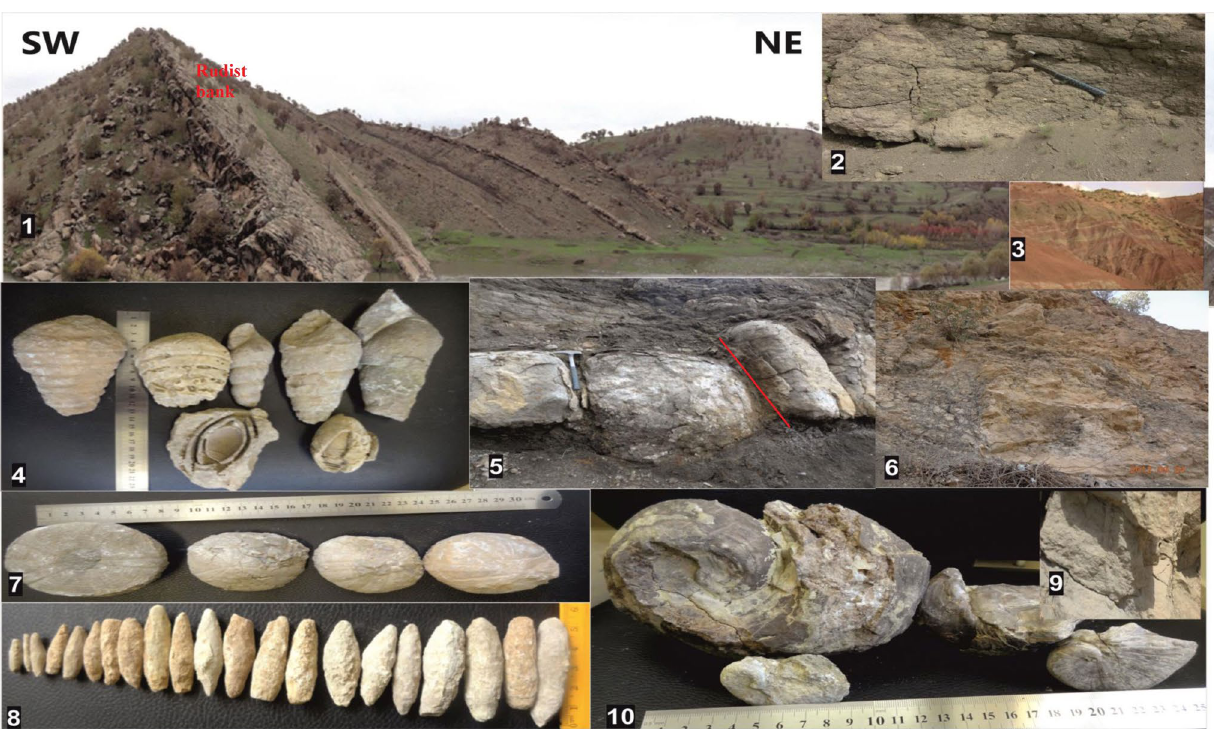
Fig. 7 1. Upper part of Aqra fn. 2. Incised valley fill (SBT.1). 3. Swais Group. 4. Turritella and Acteonella. 5. and 6. Slumped blocks (Dokan section). 7. Echinoides from Zardabee section. 8. Loftusia